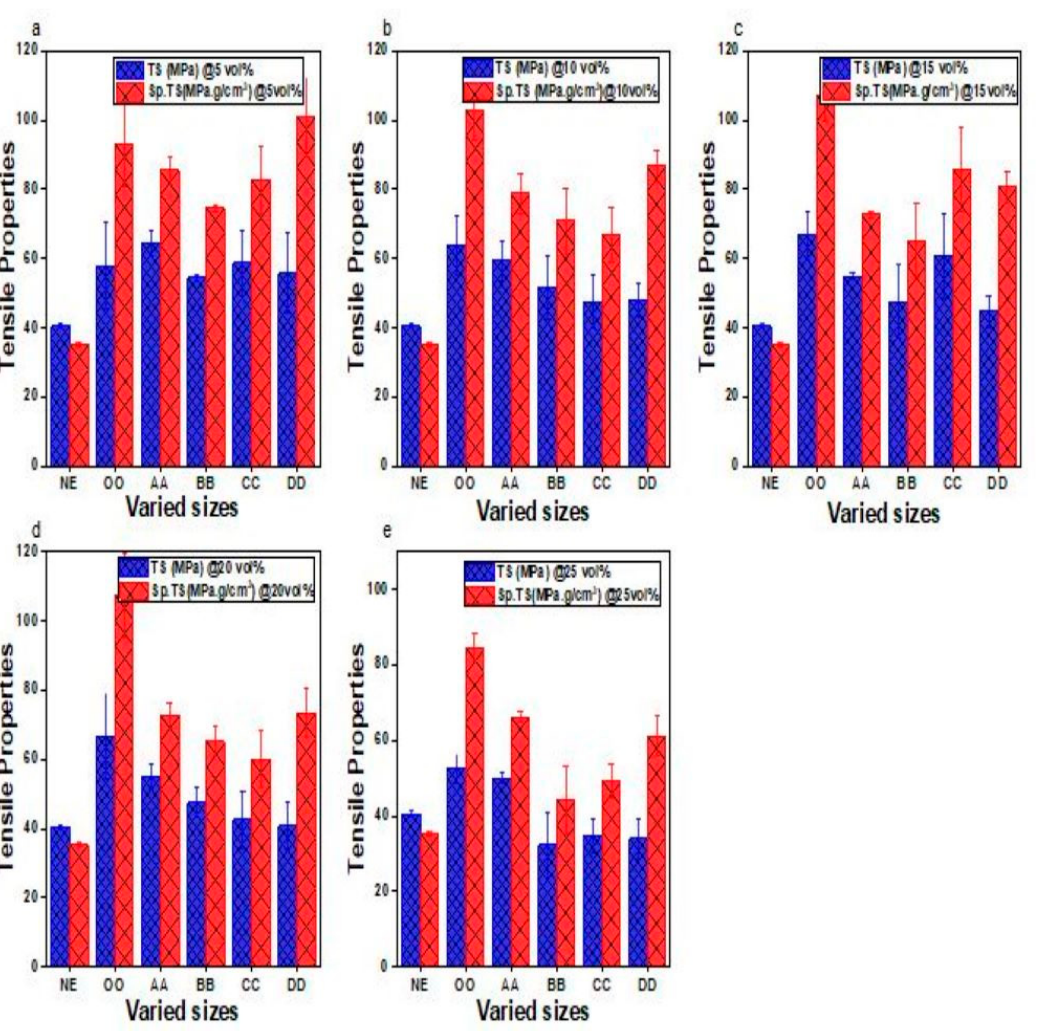
Figure 7. Graphical representation of tensile strength (TS) and specific tensile strength (SpTS) for NE, OO, AA, BB, CC, and DD: ( a ) 5 vol%; ( b ) 10 vol%; ( c ) 15 vol%; ( d ) 20 vol%; and ( e ) 25 vol%.